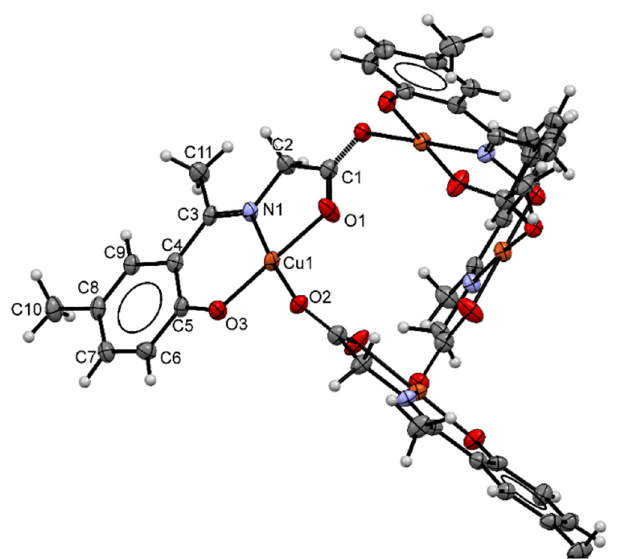
Figure 2. ORTEP drawing of complex 4 showing the atom numbering scheme and the thermal motion ellipsoids (50% probability level) for the non-hydrogen atoms.